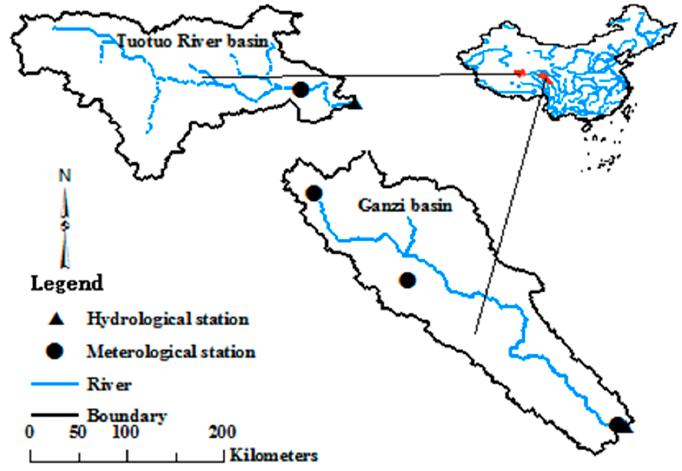
Figure 2. Location of the Tuotuo River Basin and Ganzi Basin in Western China.